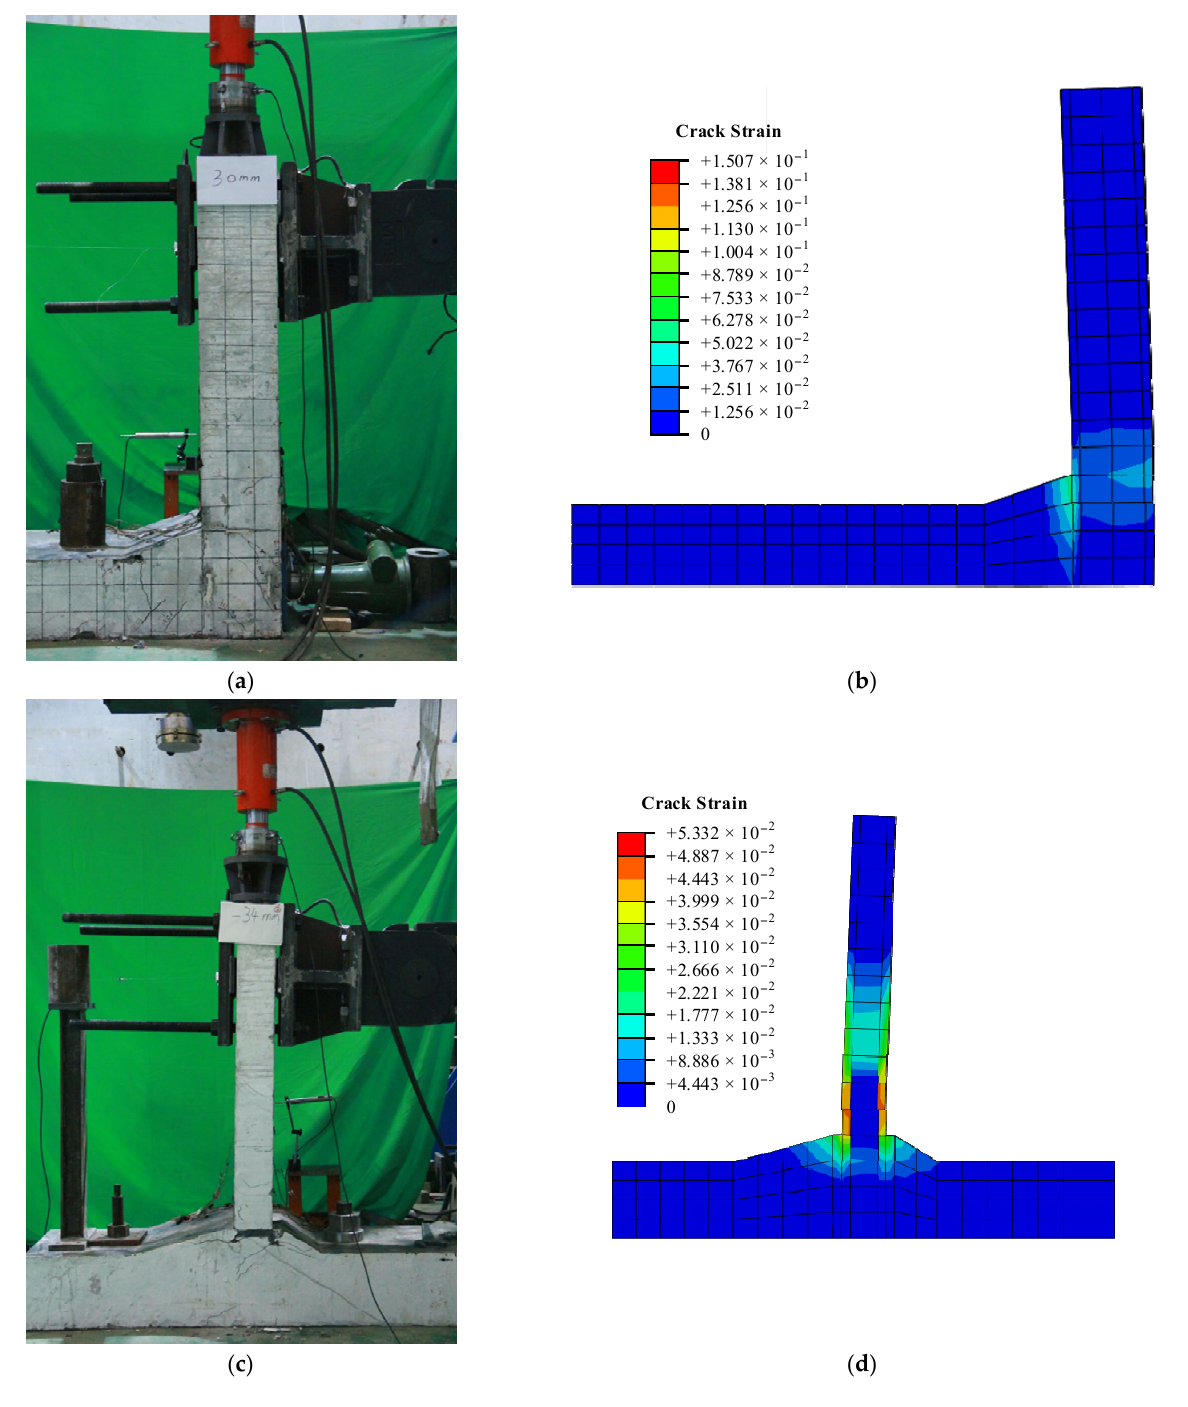
Figure 17. Comparison of the measured and calculated results of the crack distributions of specimens. ( a ) L-shaped specimen test phenomenon (30 mm); ( b ) calculated results for the L-shaped specimen (30 mm); ( c ) T-shaped specimen test phenomenon ( − 34 mm); ( d ) calculated results for the T-shaped specimen ( − 34 mm).